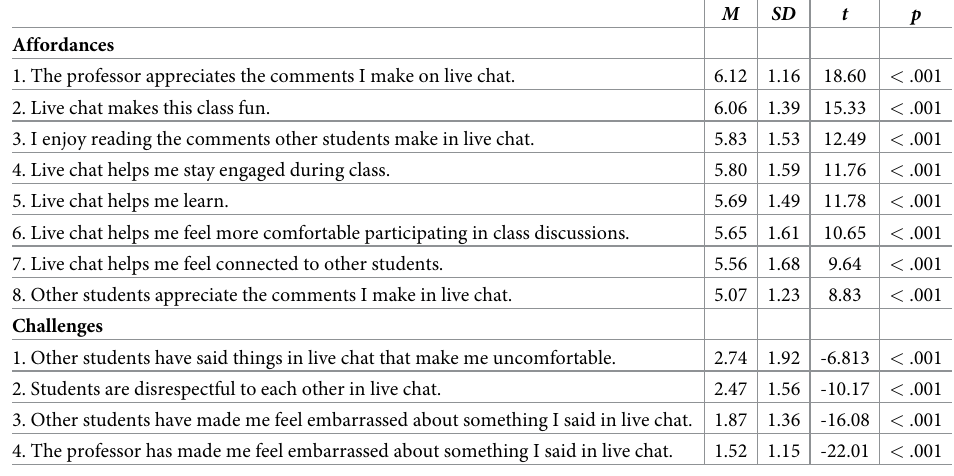
Table 1. One-sample t-test comparing student ratings against the neutral midpoint on the response